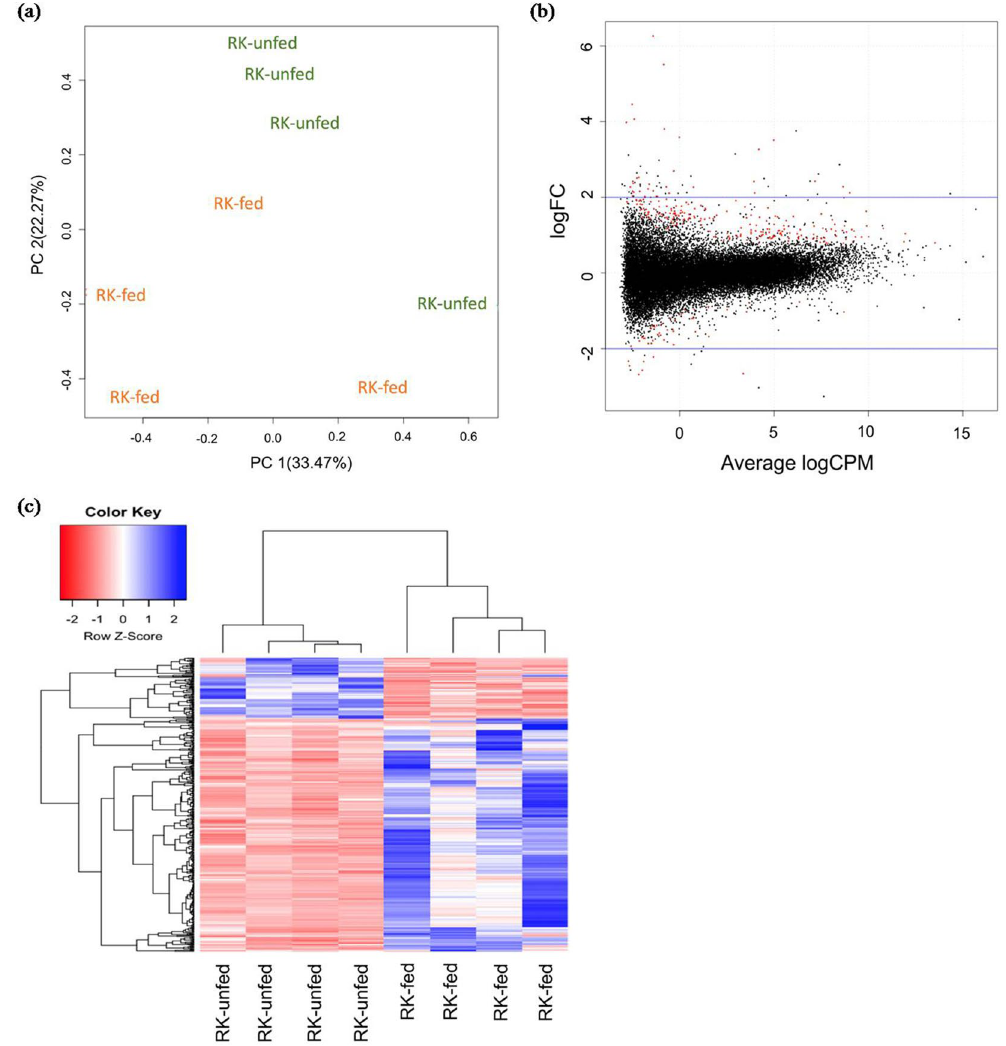
Figure 4. Differentially expressed genes (DEGs) in RK-fed, cuelure non-responding and RK-unfed, cuelure responding males. ( a ) Principal component analysis shows that colour-coded replicates show separation between conditions. ( b ) The expression profile of individual samples was explored with mean-difference (MD) plots. The differentially expressed genes are highlighted in red. The blue guidelines mark the log fold changes between ± 2. ( c ) Heatmap of all DEGs from all samples, with unsupervised hierarchical clustering on X and Y axes; drawn with coolmap function [https:// rdrr. io/ bioc/ limma/ man/ coolm ap. html] from bioconductor limma (3.48.1) package 59 . Clustering of samples was evident, as was clustering of genes that had correlated expression